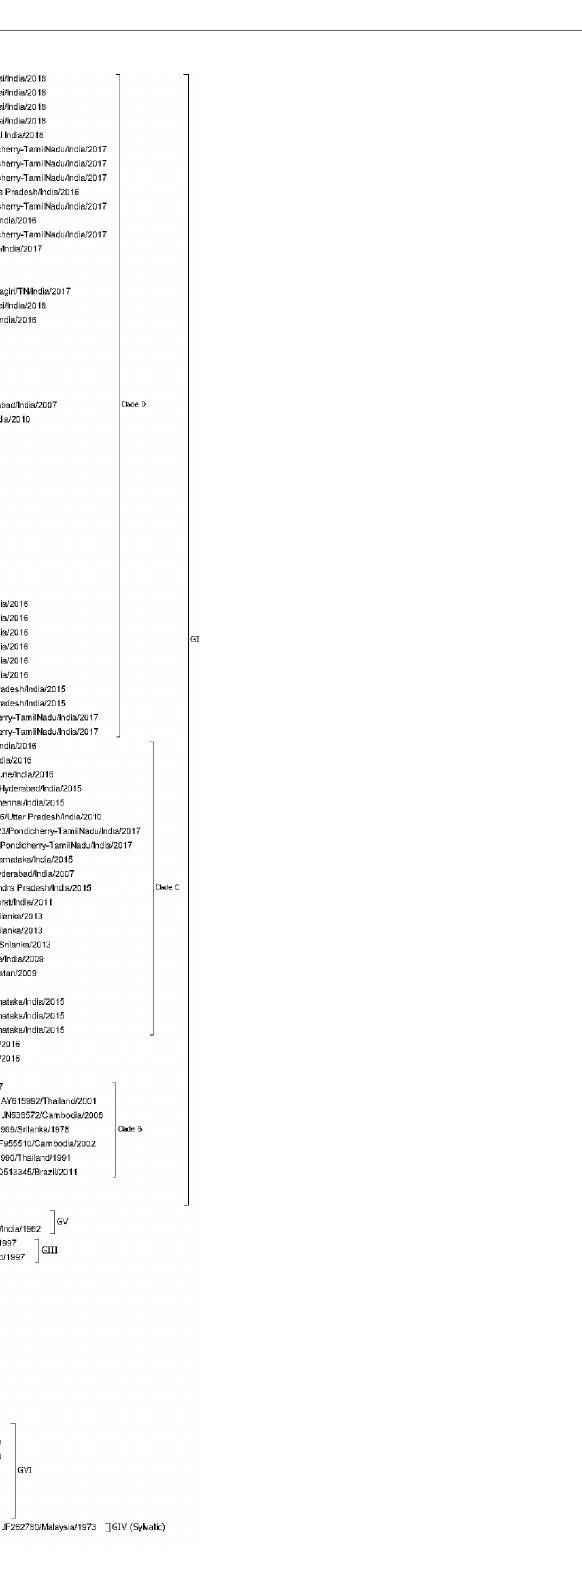
FIGURE 4 | Phylogeny of DENV-4. The phylogeny of DENV-4 was inferred by using the ML method. The tree with the highest log likelihood (-1,324.25) is shown. The analysis involved 103 nucleotide sequences. There was a total of 271 positions in the fi nal dataset. Nineteen sequences from this study were grouped under clade D of GI, and one sequence was grouped under clade C of GI. The nucleic acid substitution per position was calculated as 0.02.